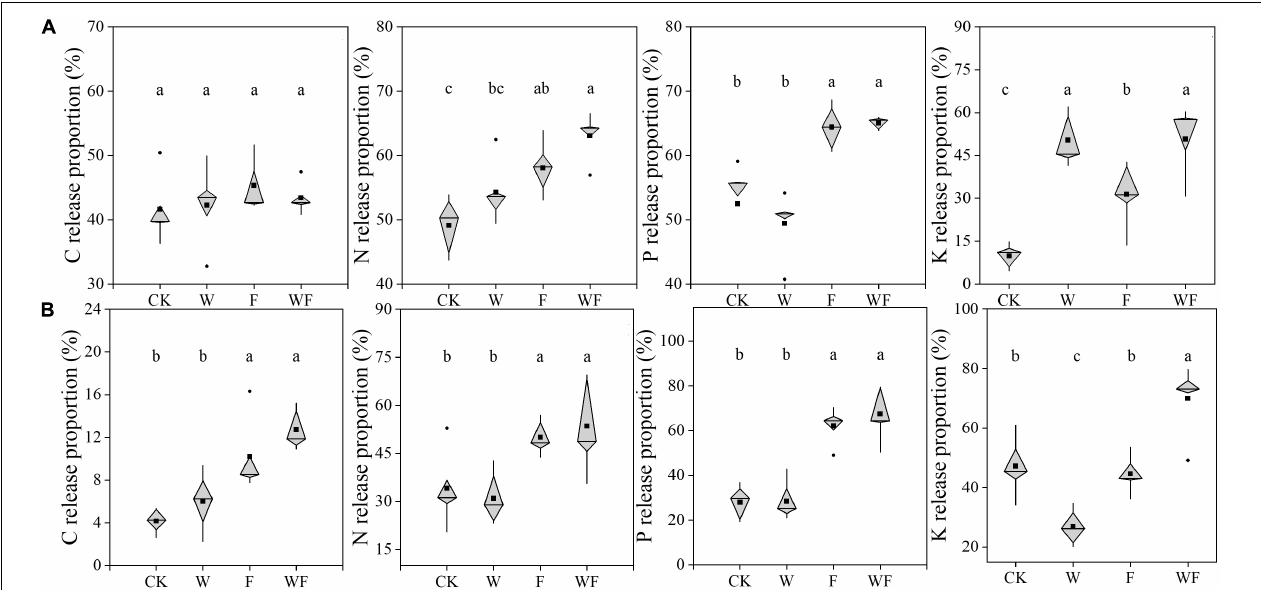
Figure 6 | The proportions of nutrient released to soil from leaf (A) and twig (B) litter bags after 360 days ( n = 5). Data were shown as boxplots. The center line of the box represents the median, the box represents the inter -quartile range (IQR), the whiskers extend 1.5 times IQR, black dot represents the value outside 1.5 the IQR, and black square represents the mean value. The letters over the boxes represented the Duncan’s multiple comparison results. Different lowercase letters indicated significant differences between various treatments ( P <